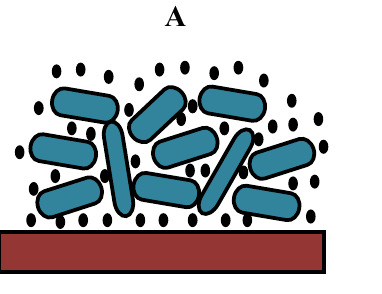
Figure 14. A hypothetical model for protein adsorption on an oxygen plasma-treated (hydrophilic) surface with trapped water molecules ( A ) and a CF (hydrophobic) surface ( B